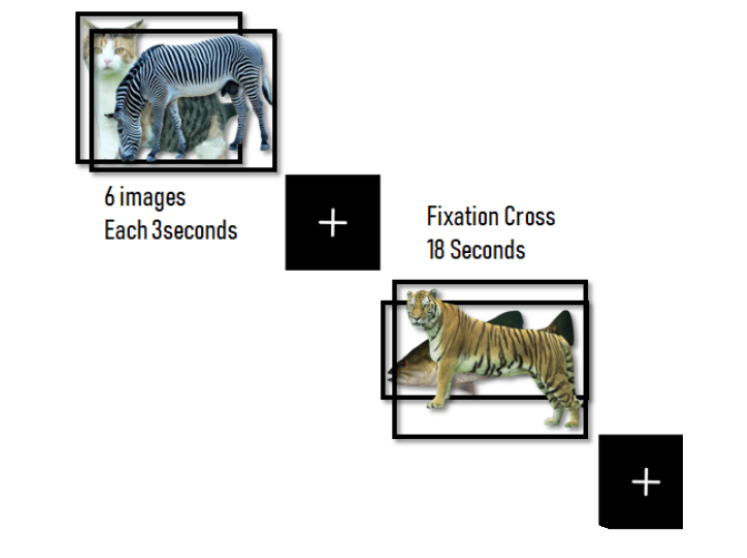
Figure 1. The naming task designed with